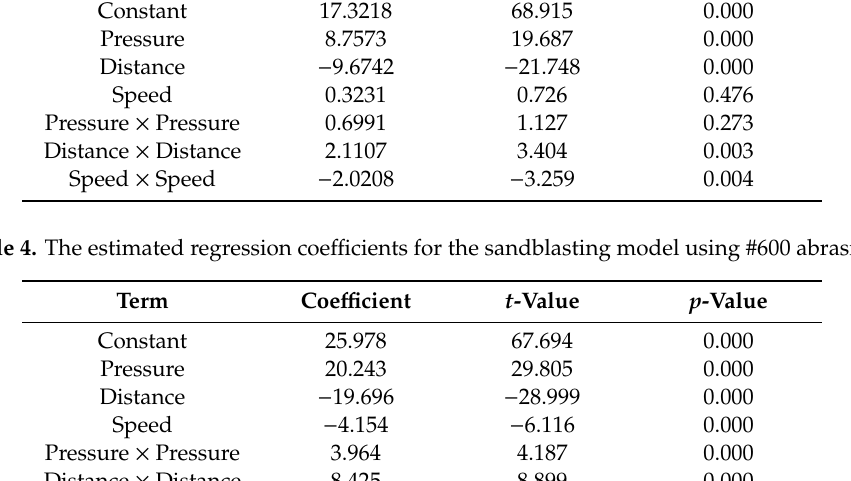
Table 3. The estimated regression coe ffi cients for the sandblasting model using #800 abrasive. Term